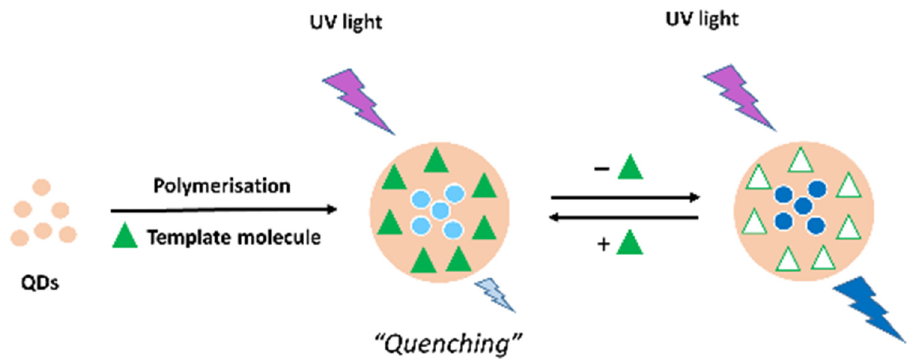
Figure 1. Schematic illustration of the general preparation procedure and possible sensing mechanism of QD-MIPs.